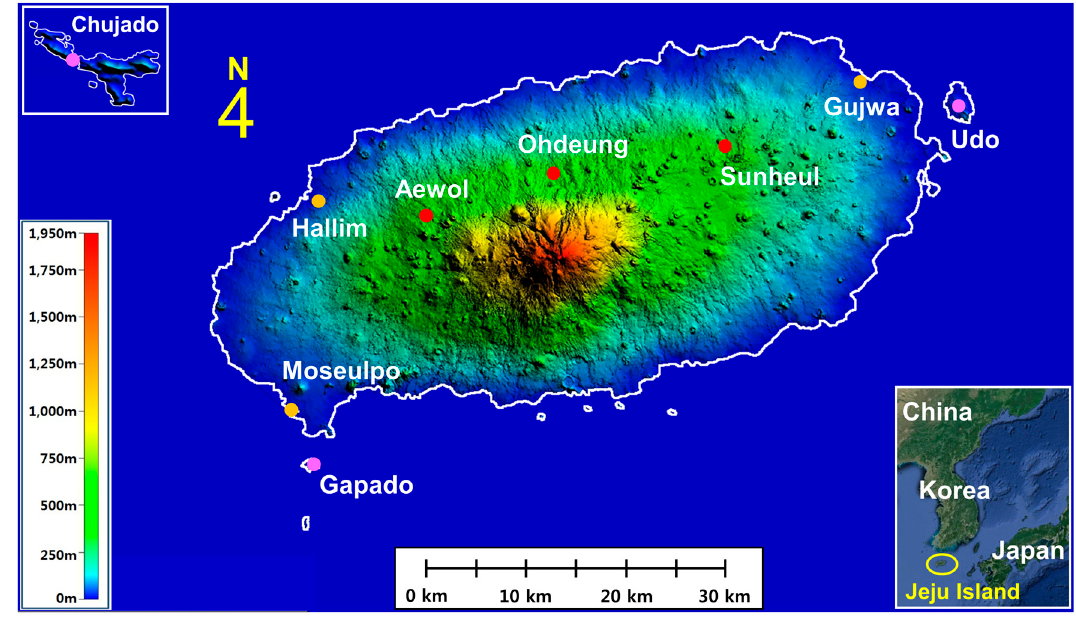
Figure 1. Location of Jeju Island and its measurement sites.